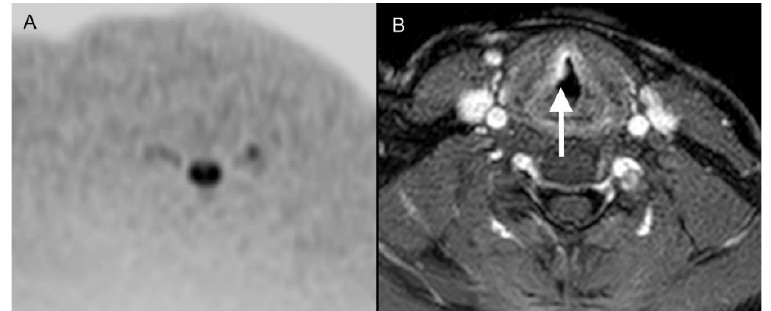
Figure 2. ( A ) A 37-year-old patient with a pT1a cN0 cM0 squamous cell carcinoma of the right vocal cord, which was not detectable in DWIBS ( A ) but was correctly diagnosed in contrast-enhanced transversal T1-weighted scans with fat saturation (( B ); white arrow) by both